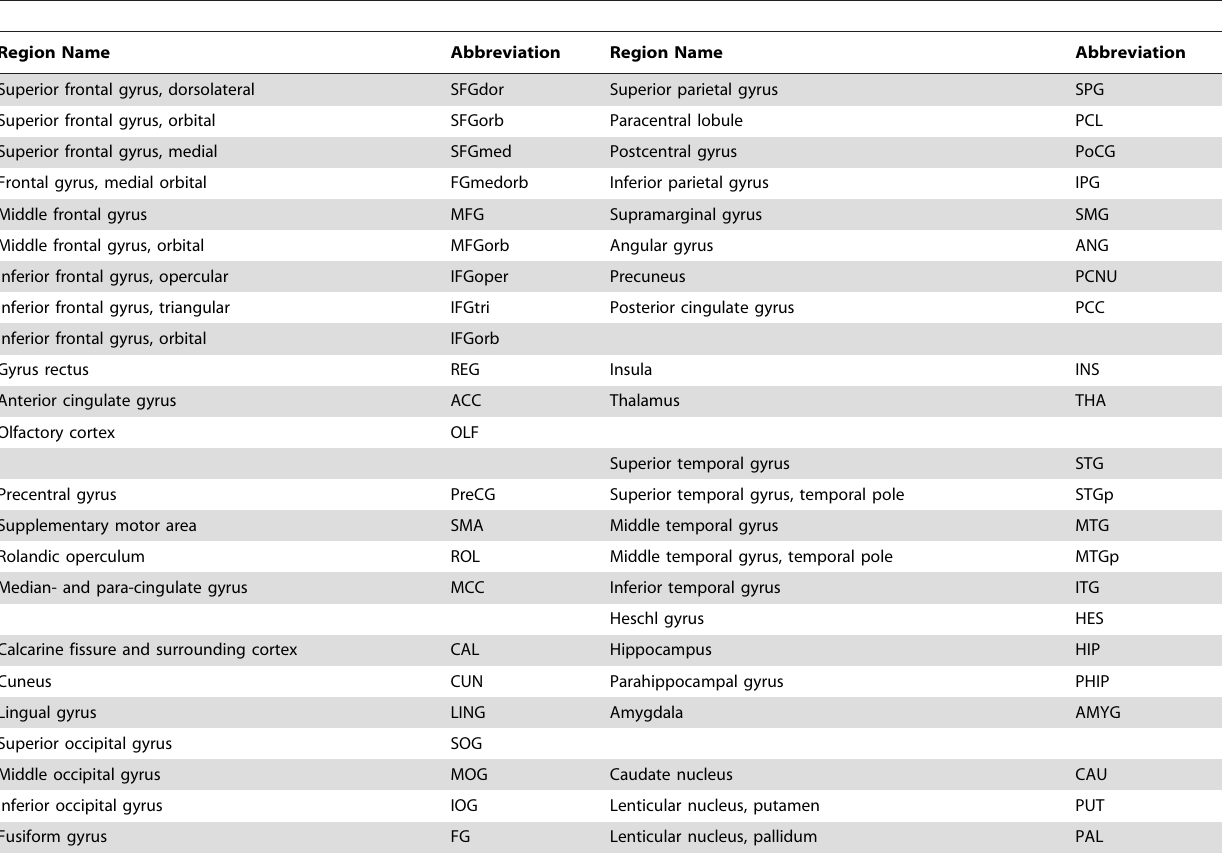
Table 2. Cortical and subcortical regions defined in Automated Anatomical Labeling template image in standard stereotaxic space.